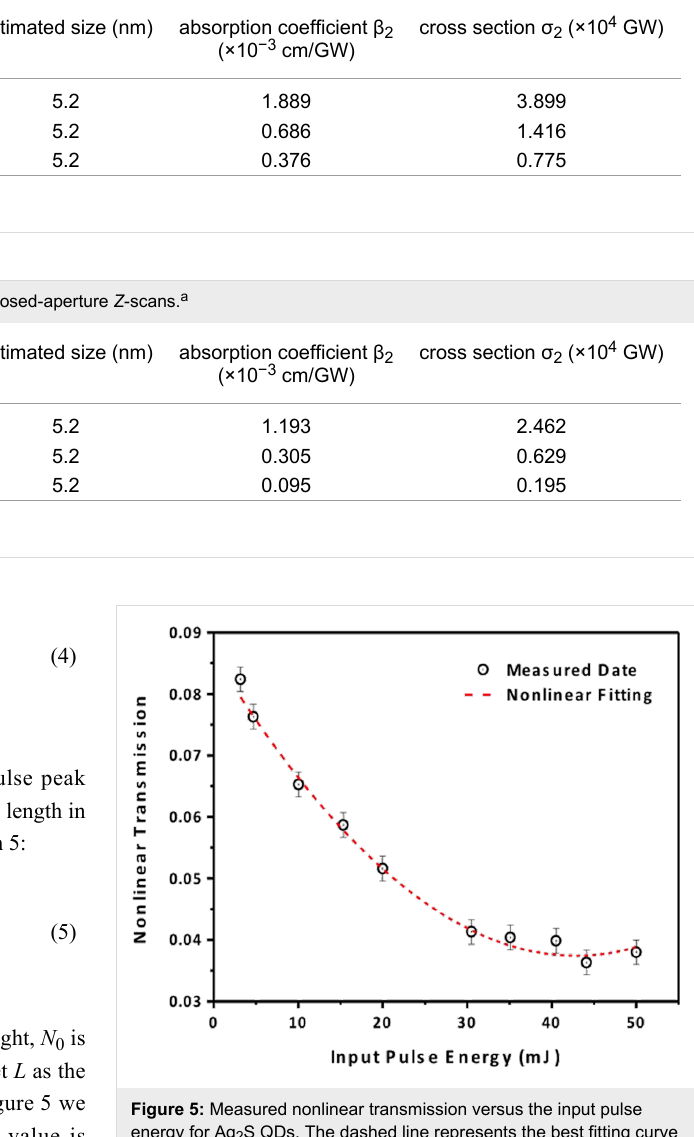
Table 2: Fitted nonlinear optical parameter of Ag 2 S QDs for open-aperture Z -scans. a